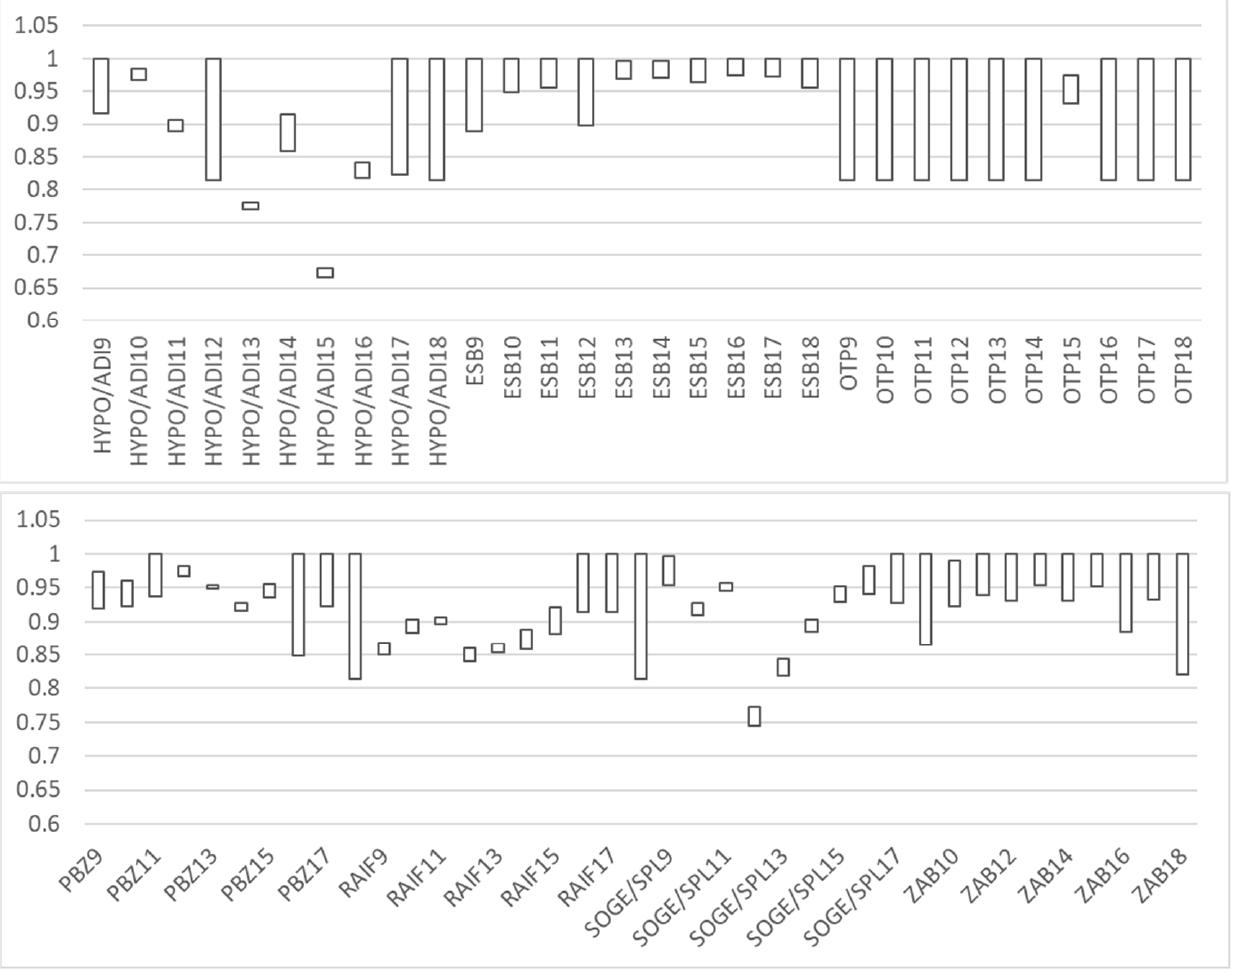
Figure 2. Bias-corrected BCC scores, lower and upper 95% confidence intervals. Moreover, the difference in the efficiency of ESB and ZAB is not pronounced; the ranges of their bootstrapped efficiency scores overlap to a large degree. PBZ is a follower of ZAB, ESB, and OTP; its 95% CIs overlap with those of OTP and ZABA in the first and last years, and the CI narrows towards inefficiency during 2012–2015. These findings are independent of the inclusion of OTP and HYPO/ADI in our sample, meaning that similar results would be achieved using the sample without OTP (and HYPO bank in